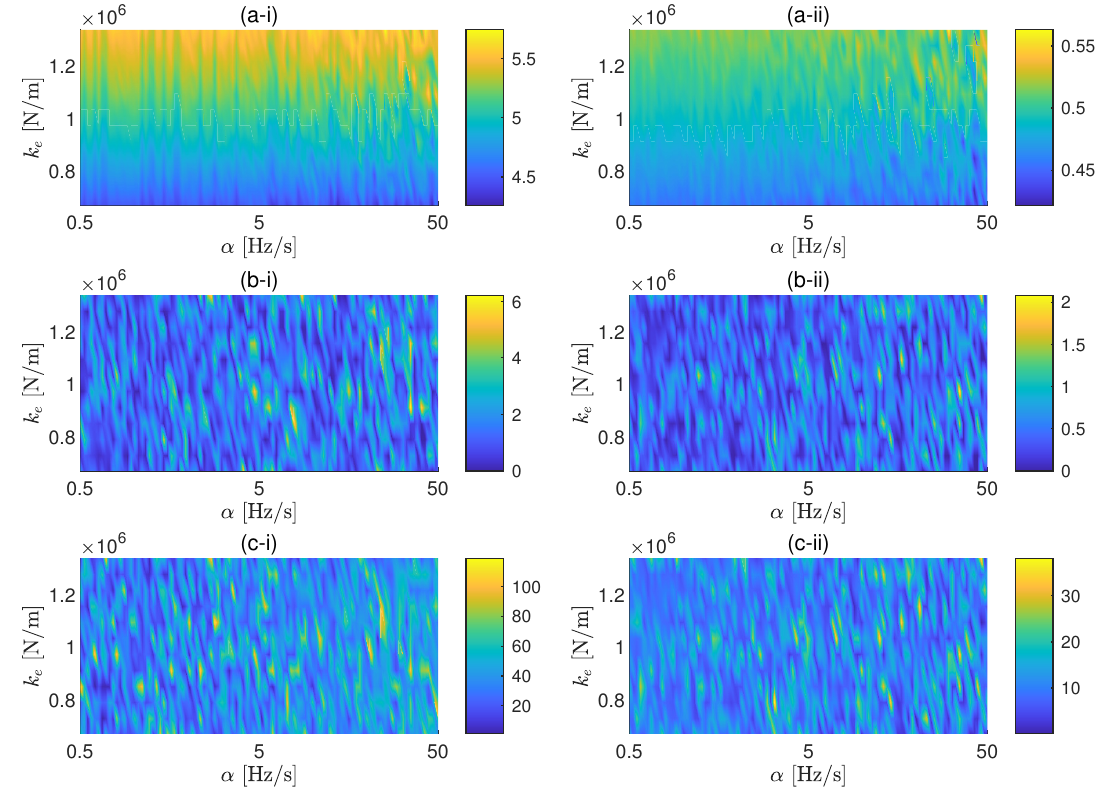
Figure 4. General ( a ), resonance frequency ( b ) and resonance amplitude ( c ) errors as a function of the sweep rates and the dynamic stiffness of the elastomer for excitation force amplitudes of 1.5 N (i) and 15 N (ii). Background noise: 3.3 × 10 − 8 m/s 2